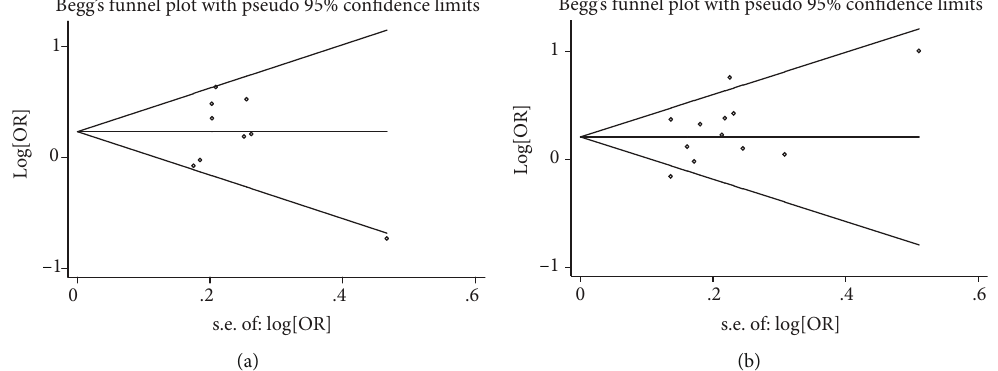
Figure 2: Begg ’ s funnel plot for the association between rs2010963 and NPDR as well as PDR in the dominant model. (a) Begg ’ s funnel plot for the association between rs2010963 and NPDR in the dominant model. (b) Begg ’ s funnel plot for the association between rs2010963 and PDR in the dominant